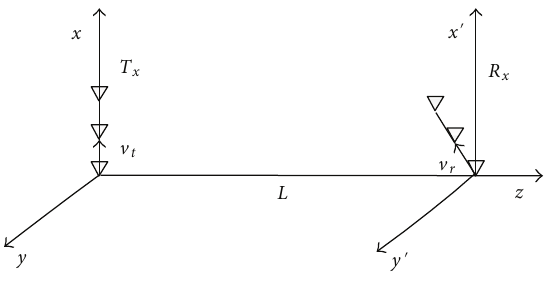
Figure 1: Linear antenna array with equal spacing.